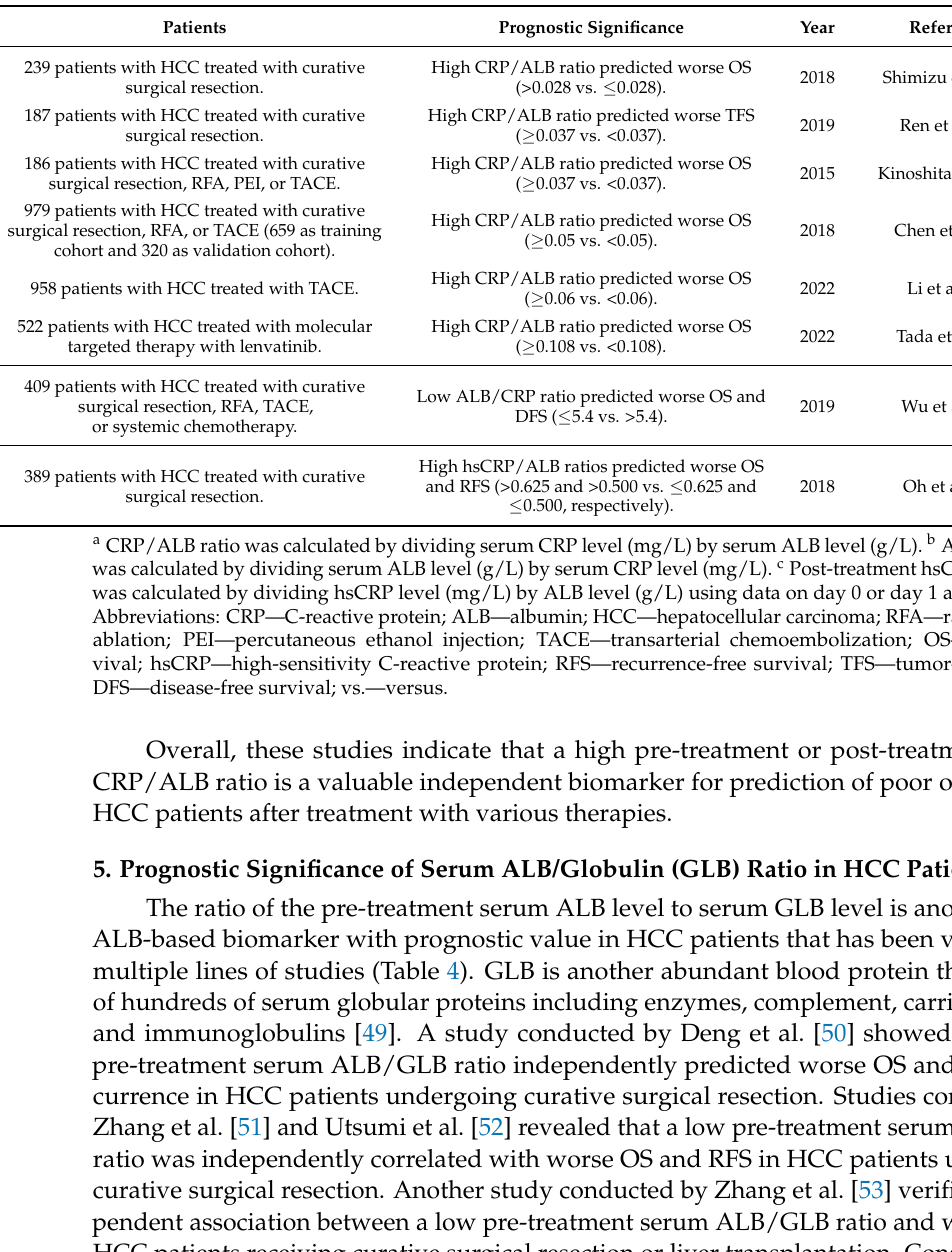
Table 3. Prognostic significance of serum CRP/ALB ratio in HCC